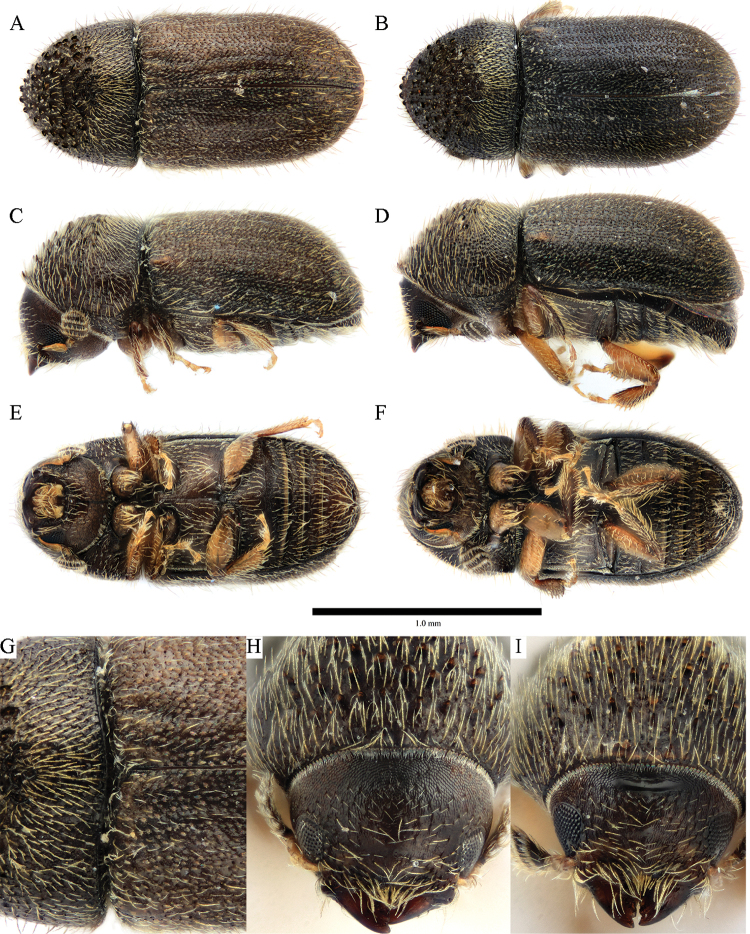
Cryphalus
exiguusA, C, E, G female, UFFE:34070 B, D, F, H male, UFFE:21476.